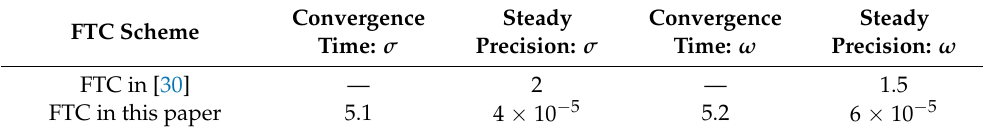
Table 3. Comparative analysis of performance with proposed FTC without fault estimation.